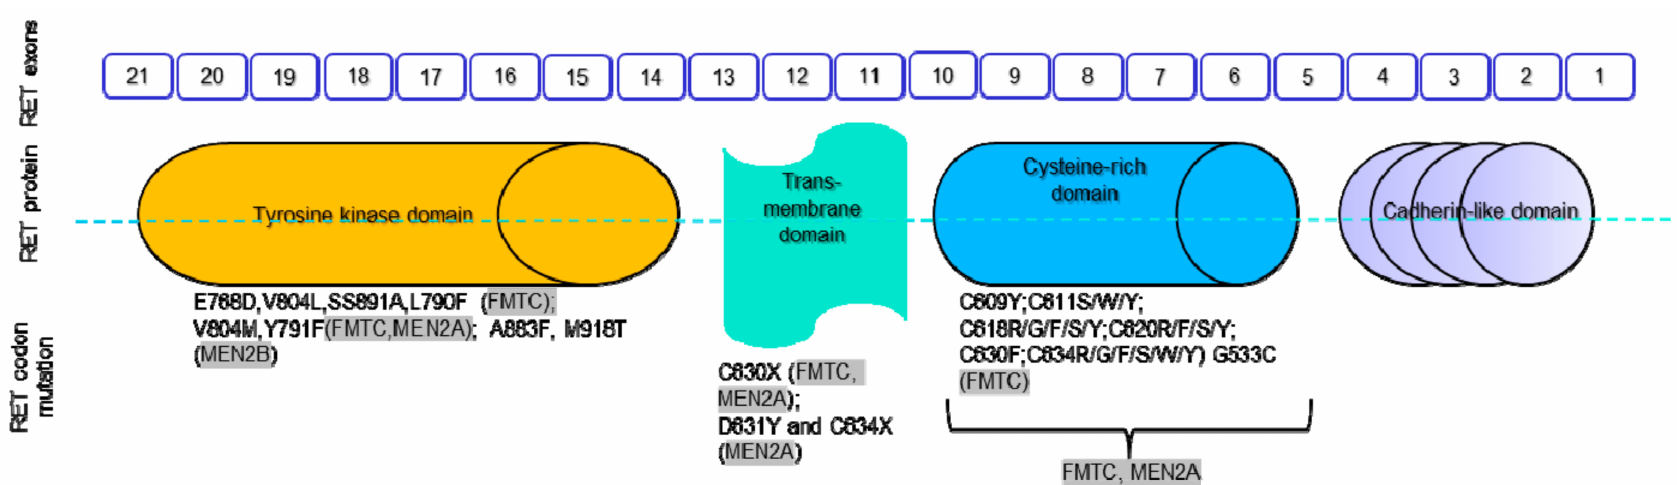
Figure 2. Schematic structure of RET, and mutations identified in MEN2A, MEN 2B and familial medullary thyroid carcinoma (FMTC). Modified from